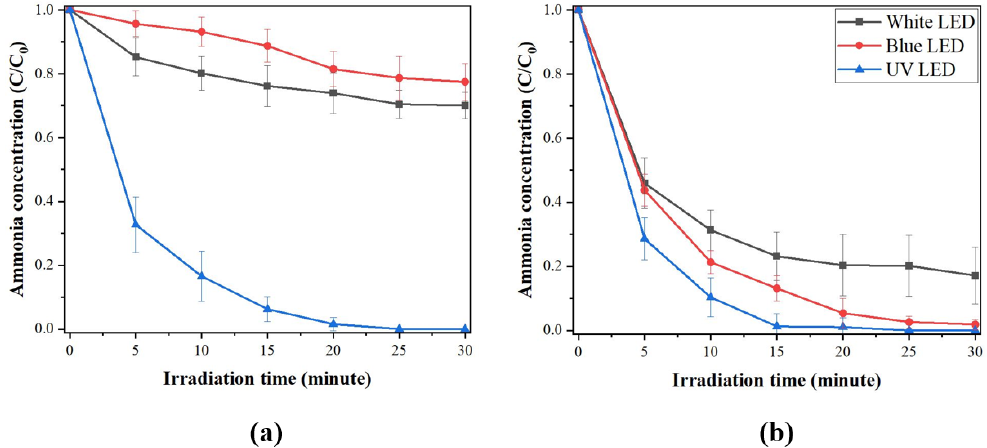
Figure 11. NH 3 photocatalytic degradation capacity of ( a ) TiO 2 /Al 2 O 3 HF membrane and ( b ) S,N- doped TiO 2 /Al 2 O 3 HF membrane under white, blue, and UV LED light sources (reactor #1).